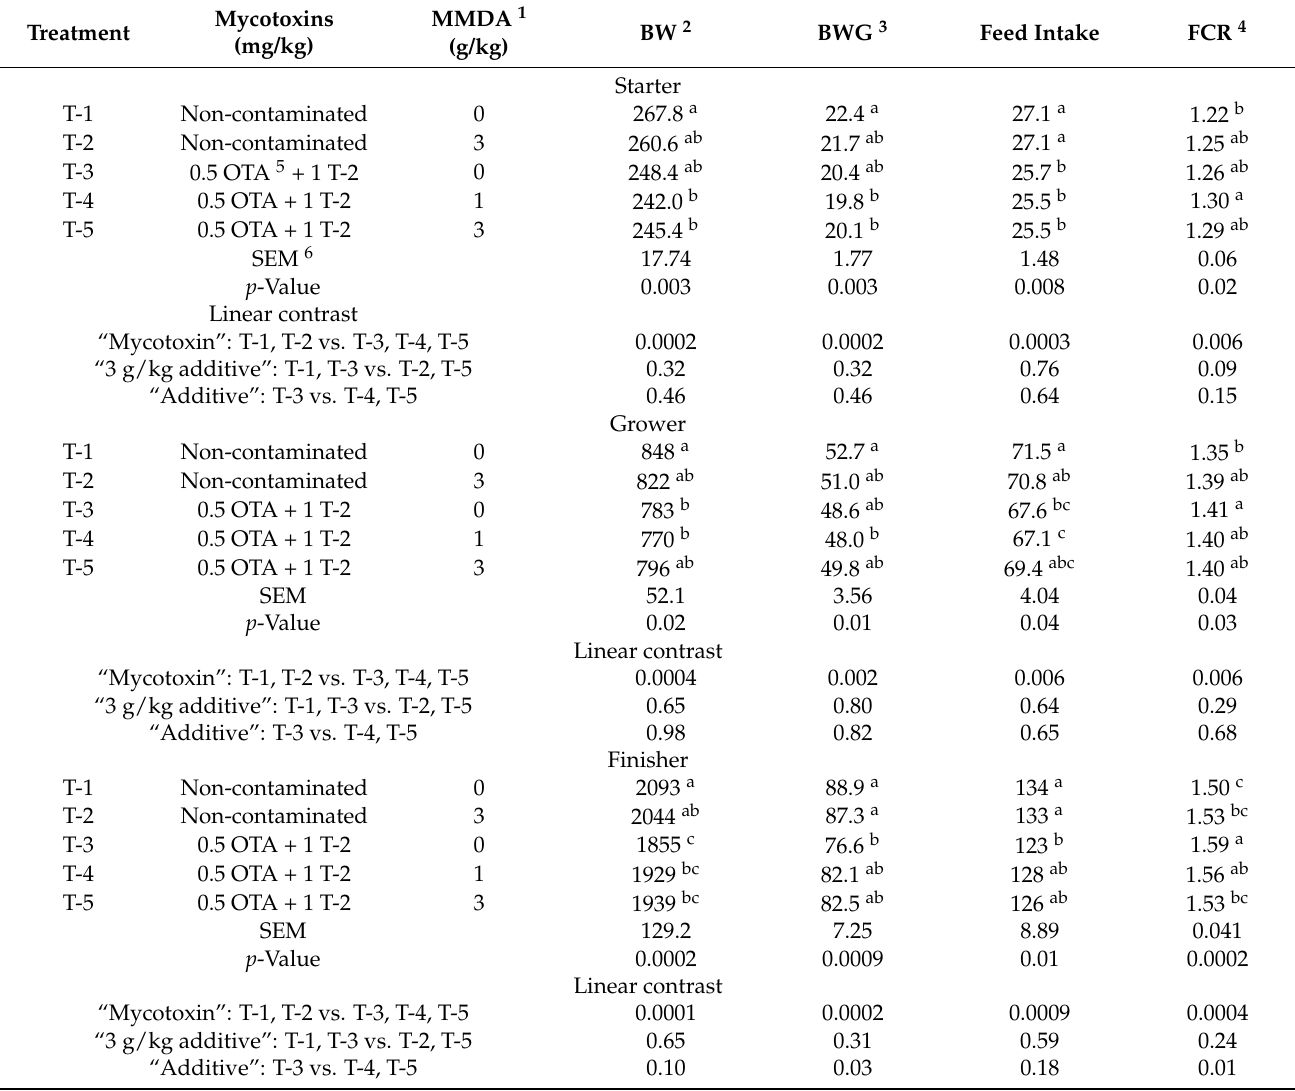
Table 3. Effects of feeding ochratoxin A (OTA) and T-2 mycotoxins and the addition of a mycotoxin binder product (MMDA) on broiler chickens